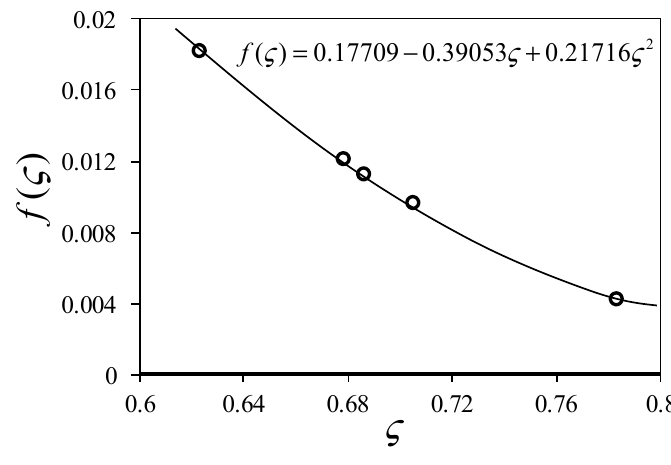
ς . Figure 13. Determination of f ( ς )